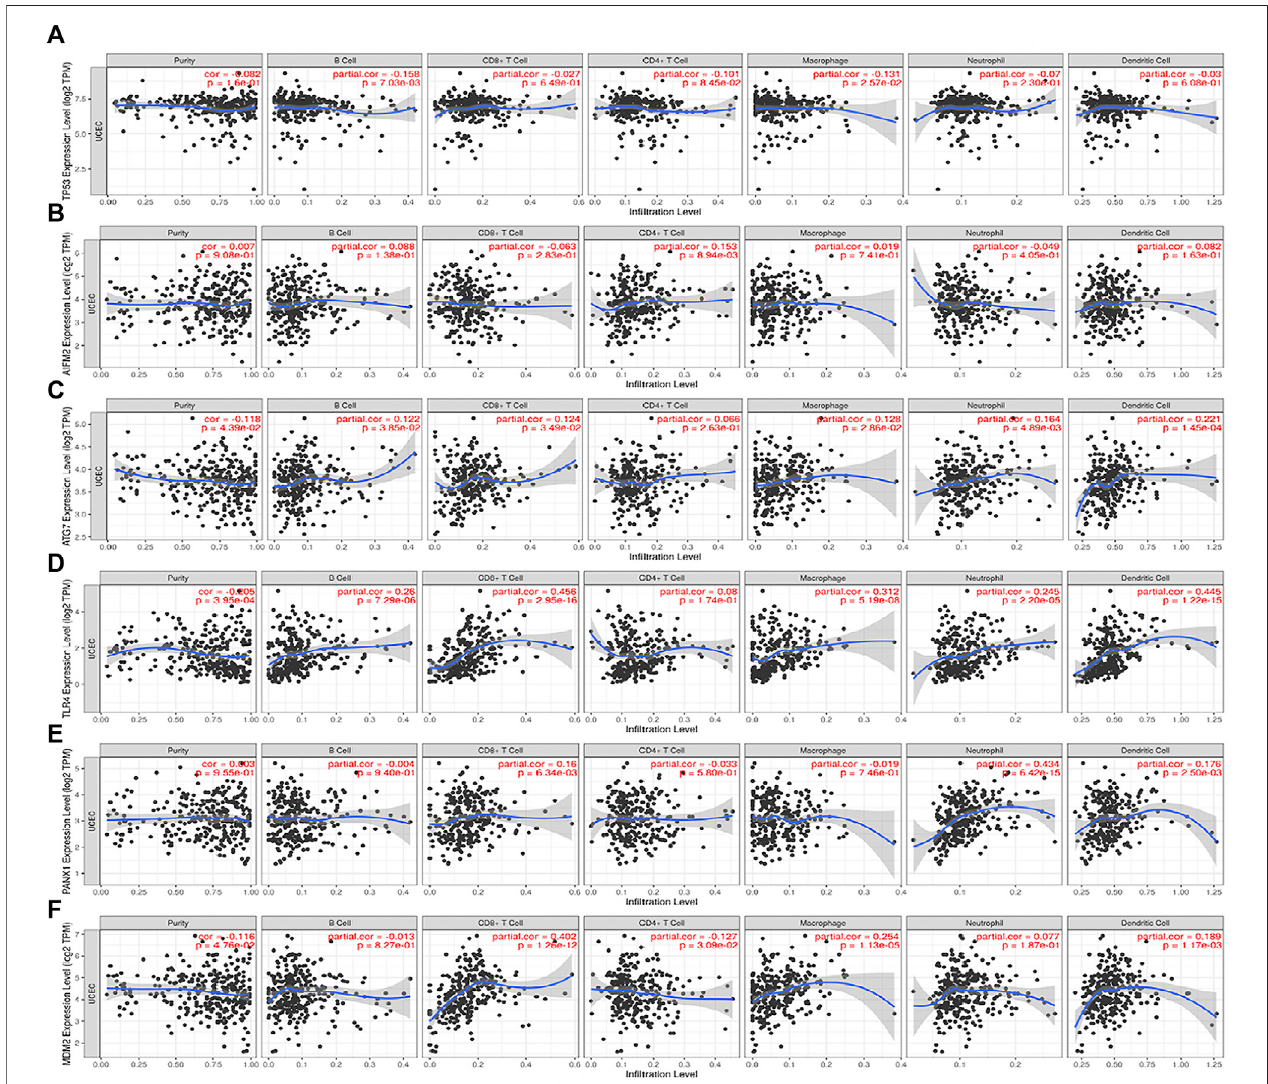
FIGURE 5 | The correlations between the expression of 6 FRGs and immune cells from the TIMER database. (A) TP53 and immune cells; (B) AIFM2 and immune cells; (C) ATG7 and immune cells; (D) TLR4 and immune cells; (E) PANX1 and immune cells; (F) MDM2 and immune cells.